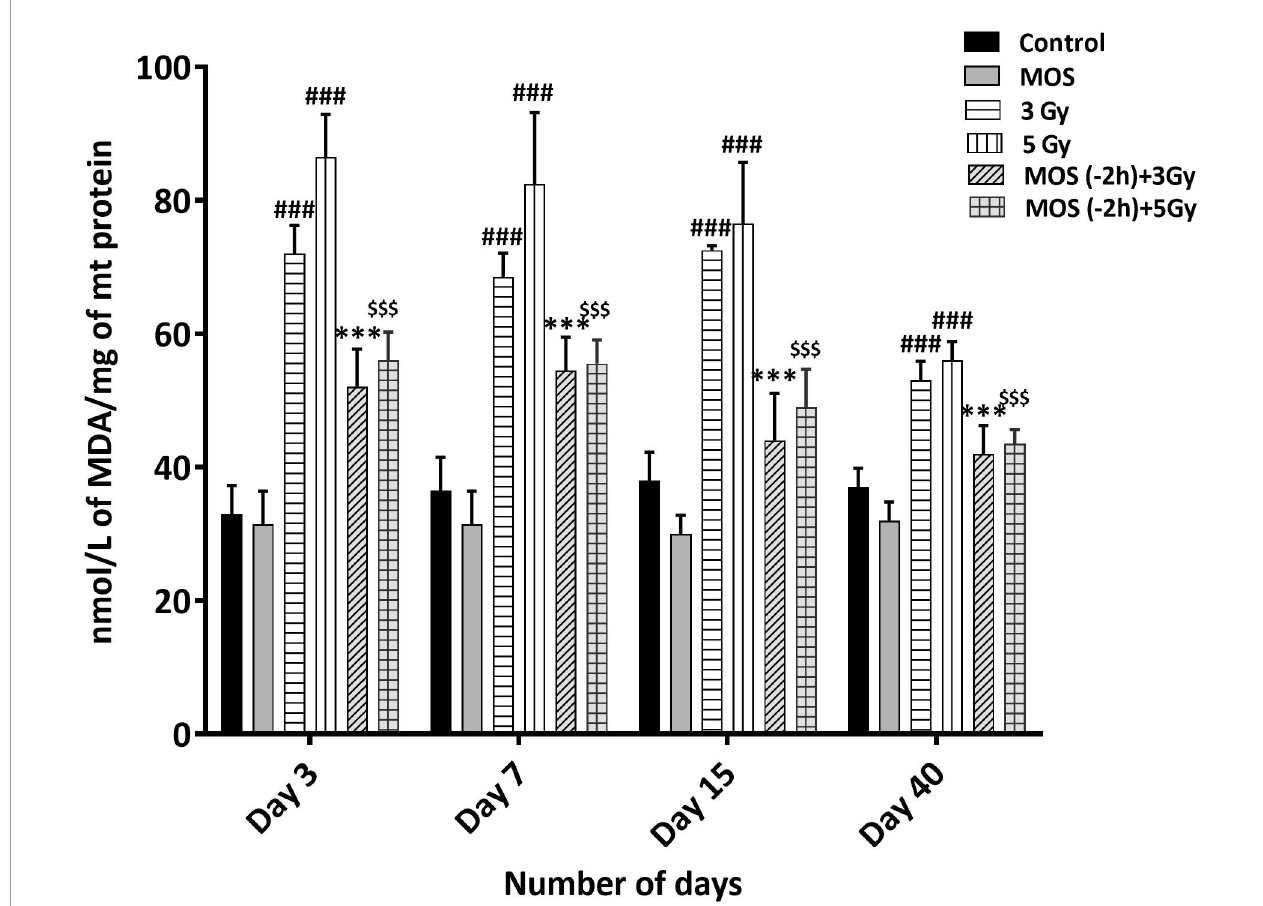
FIGURE 7 | Lipid peroxidation assay: Mice were treated with MOS (200 mg/kg bw) and/or subjected to TBI (3 and 5 Gy) and assessed for MDA levels in mice kidney mitochondria as described in Materials and Methods . Error bars represent mean ± SD, ### p < 0.001 were considered signi fi cant compared to un-irradiated control group, *** p < 0.001 were considered signi fi cant compared to irradiated group and $$$ p < 0.001 were considered signi fi cant compared to 5 Gy irradiated